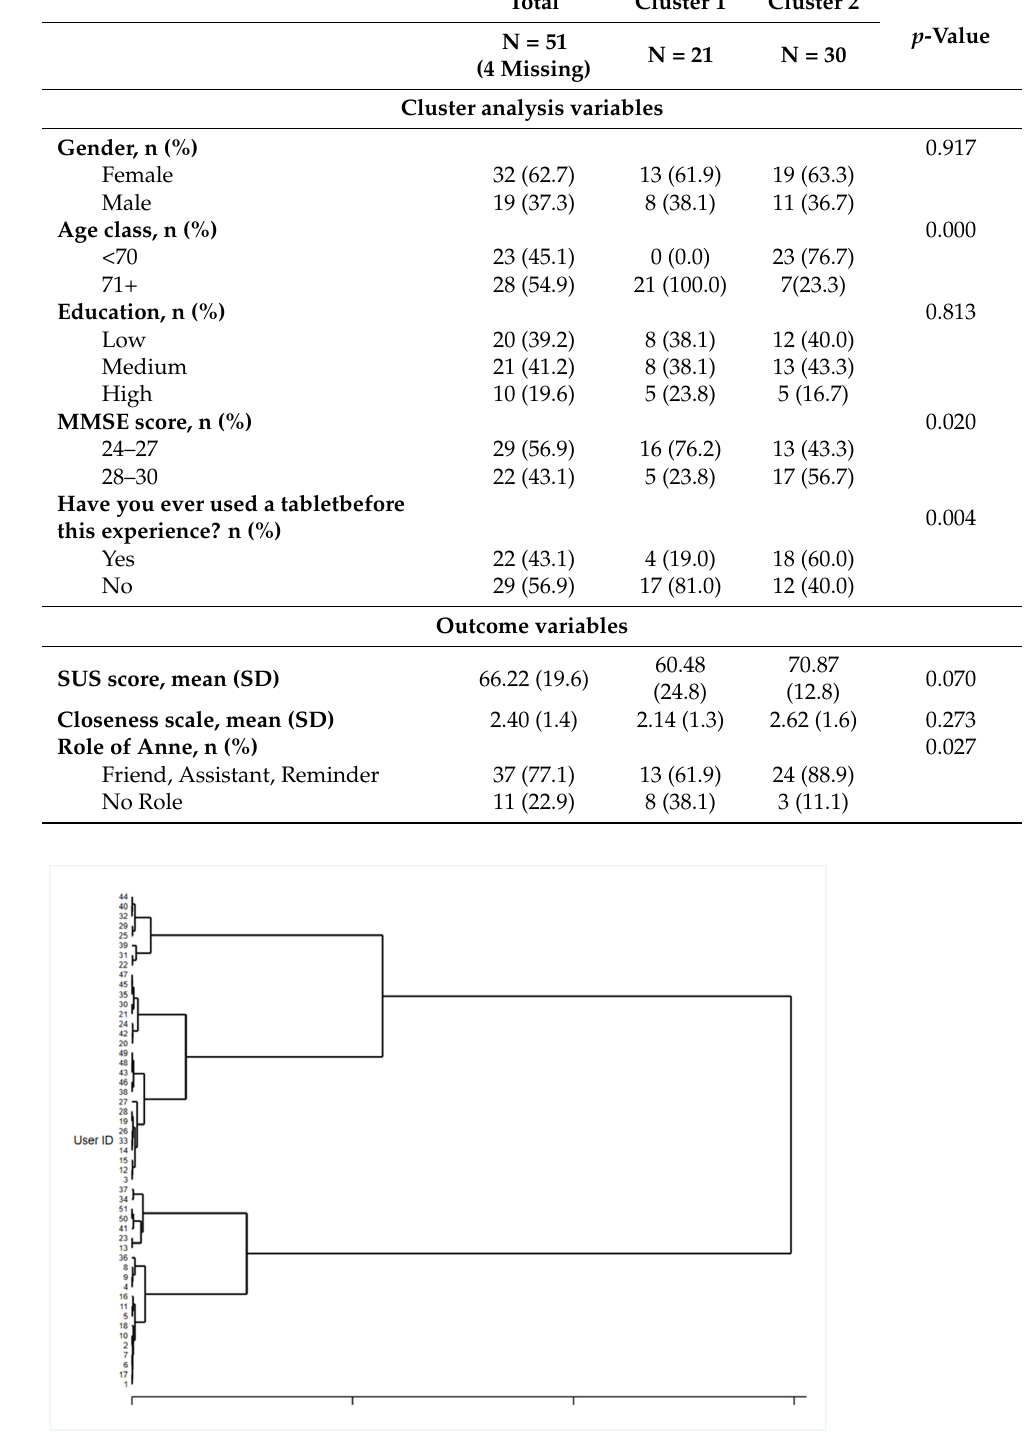
Figure 5. Hierarchical clustering dendrogram.